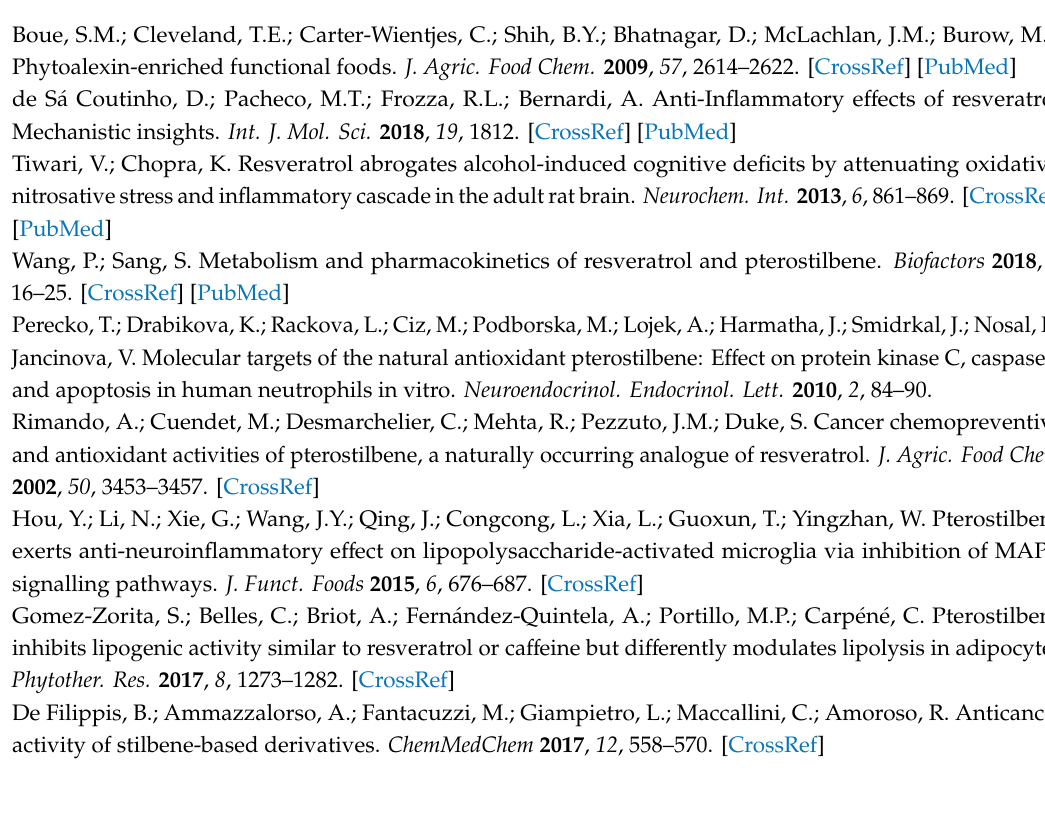
Figure S2: PTS-DSP adduct stability in PBS bu ff er at 0 and 2 h incubation, Figure S3 RP-HPLC-UV traces at 220 nm of PTS-DSP adduct in the surnatant of the reaction mixture with the agarose solid Carboxylink, Figure S4 Lists of the PTS partners in two independent experiments along with CTR experiments, Figure S5: Mascot Search Identifications of syntaxins, Figure S6: AlphaScreeen assay: Figure S7: MTT cell viability assays, Figure S8: STRING analysis of all the putative PTS partners arranged on the basis of their biological